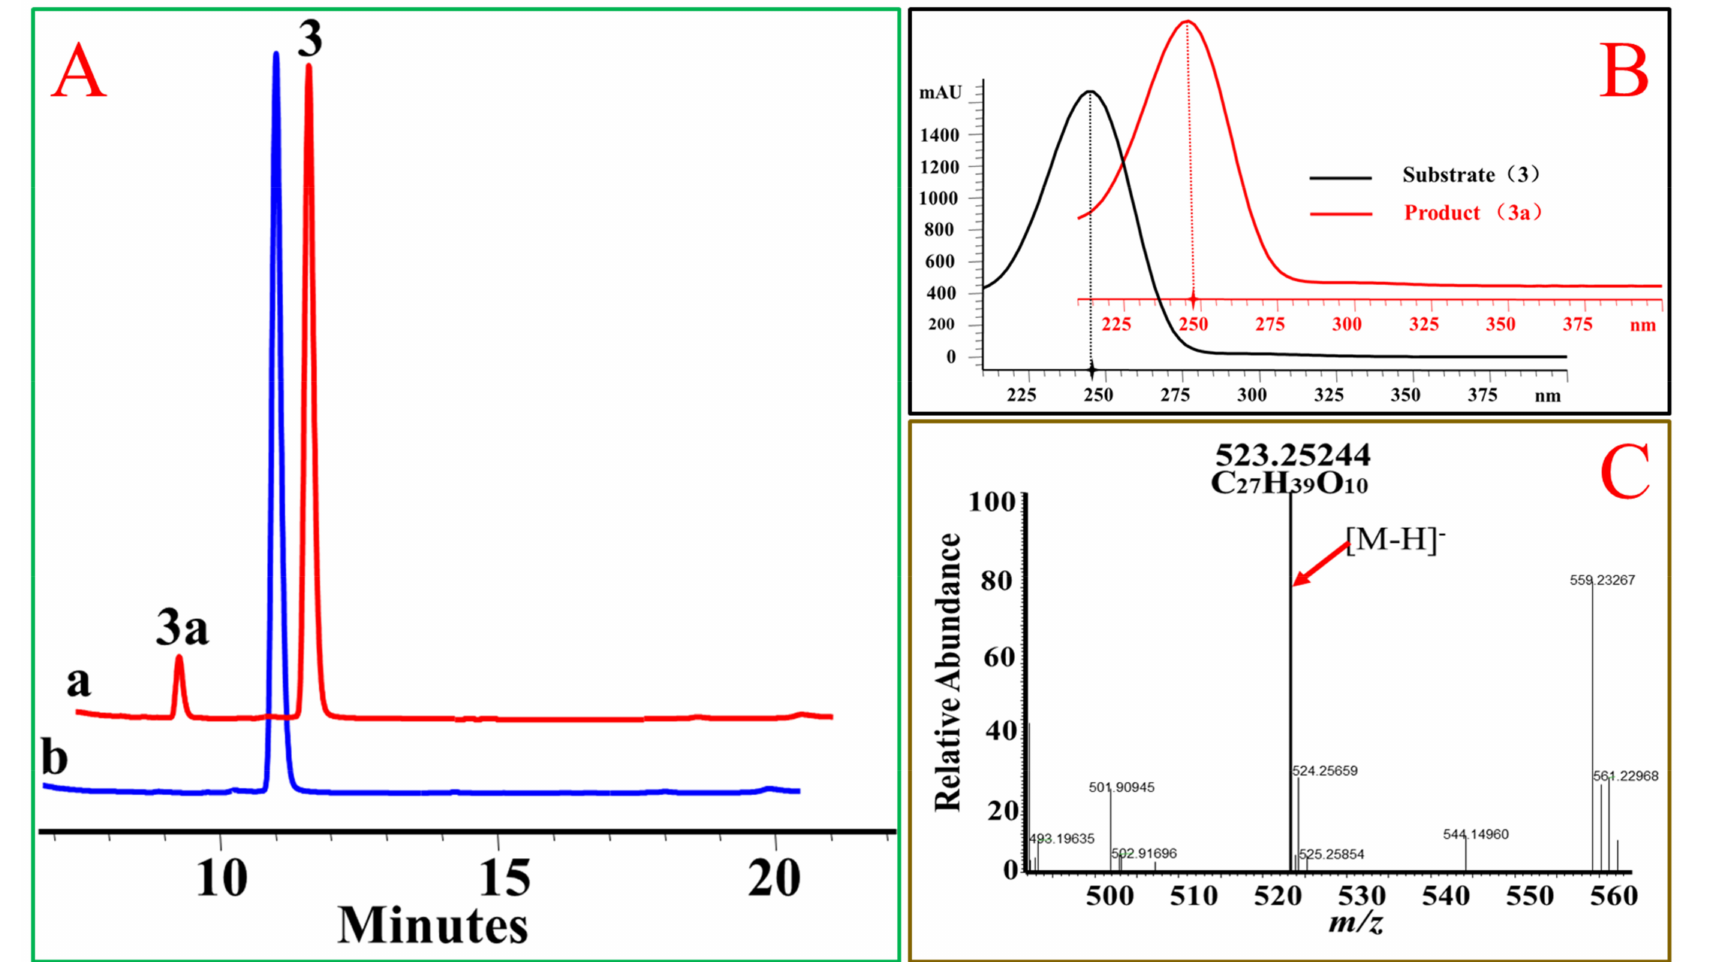
Figure 4. OcUGT1-catalyzed glucosylation towards hydrocortisone ( 3 ). ( A ) HPLC profiles of hydrocortisone ( 3 ) glucosylation. ( a ) the reaction mixture of hydrocortisone ( 3 ) with the purified OcUGT1; ( b ) the reaction mixture of hydrocortisone ( 3 ) without the purified OcUGT1. 3 and 3a refer to hydrocortisone ( 3 ) and its mono-glucoside, respectively. ( B ) UV spectra of hydrocortisone ( 3 ) and its glucosides. ( C ) HR-ESI-MS spectrum of hydrocortisone mono-glucoside ( 3a